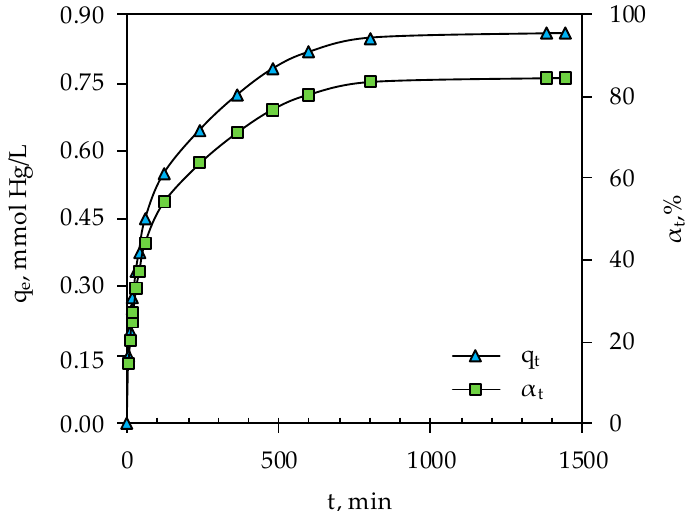
Figure 13. The quantity of Hg(II) removed per gram of SZ and removal efficiency in relation to contact time.